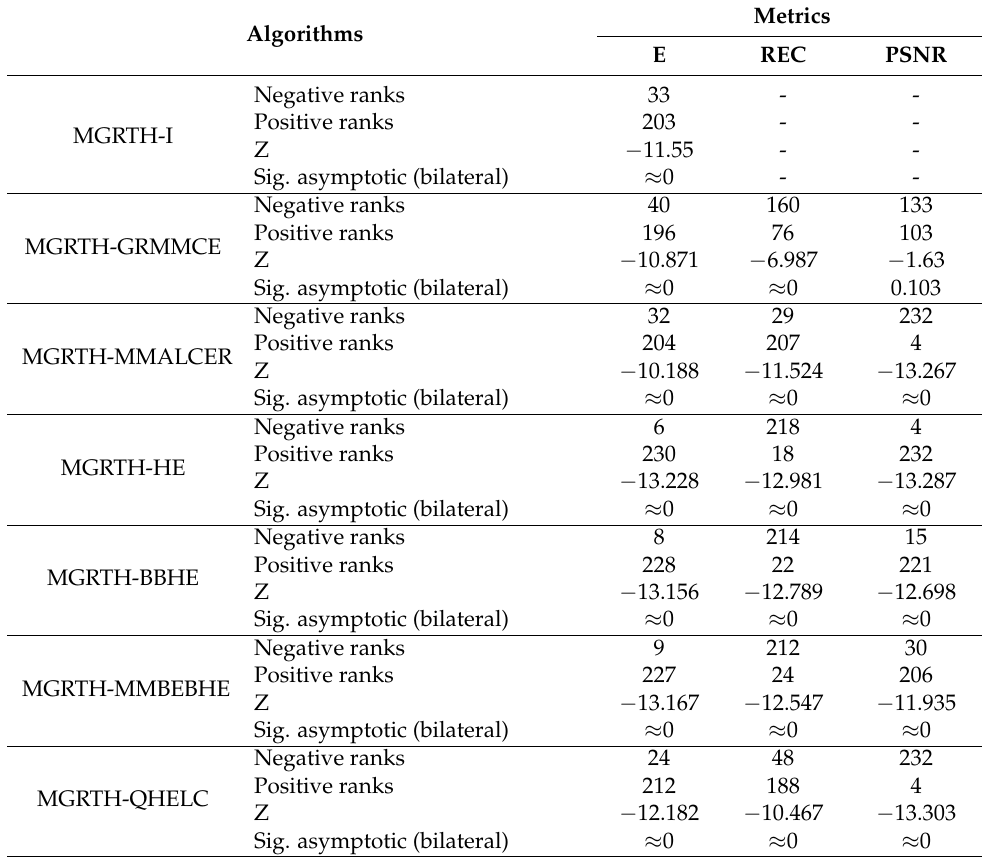
Table 4. The Wilcoxon signed rank test for paired